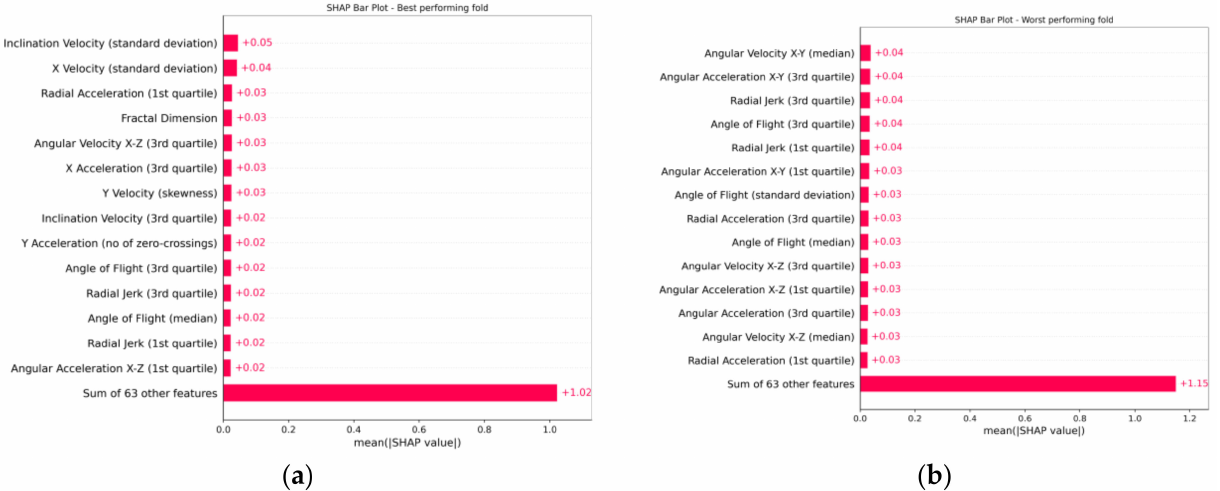
Figure 7. SHAP bar plot of the contributions of each feature to the model. The features are ordered by absolute feature contribution and the top fifteen are displayed. A full list can be found in Figures S11 and S12. ( a ) Bar plot of the best-performing fold. ( b ) Bar plot of the worst-performing